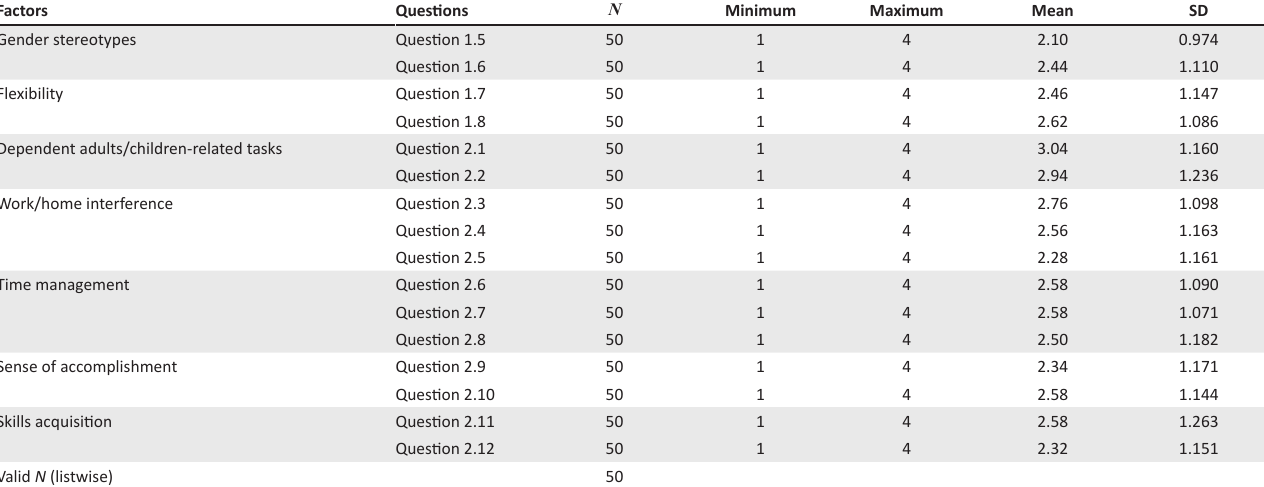
TABLE 4: Measure central tendency and dispersion for challenges information and communication technology professionals face.